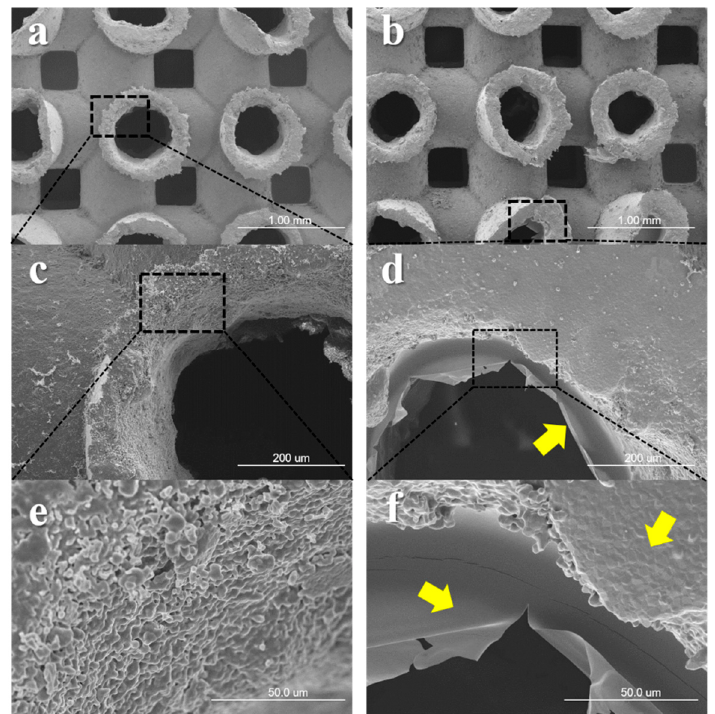
Figure 5. Captured images using scanning electron microscopy. ( a , c , e ) Boneplant group. ( b , d , f ) CMC coated groups, Boneplant/CMC, and Boneplant/CMC/BMP group. Yellow arrow: coated CMC on Boneplant surfaces [Original magnifications: ×40 ( a , b ) ×250 ( c , d ), and ×1000 ( e , f )].